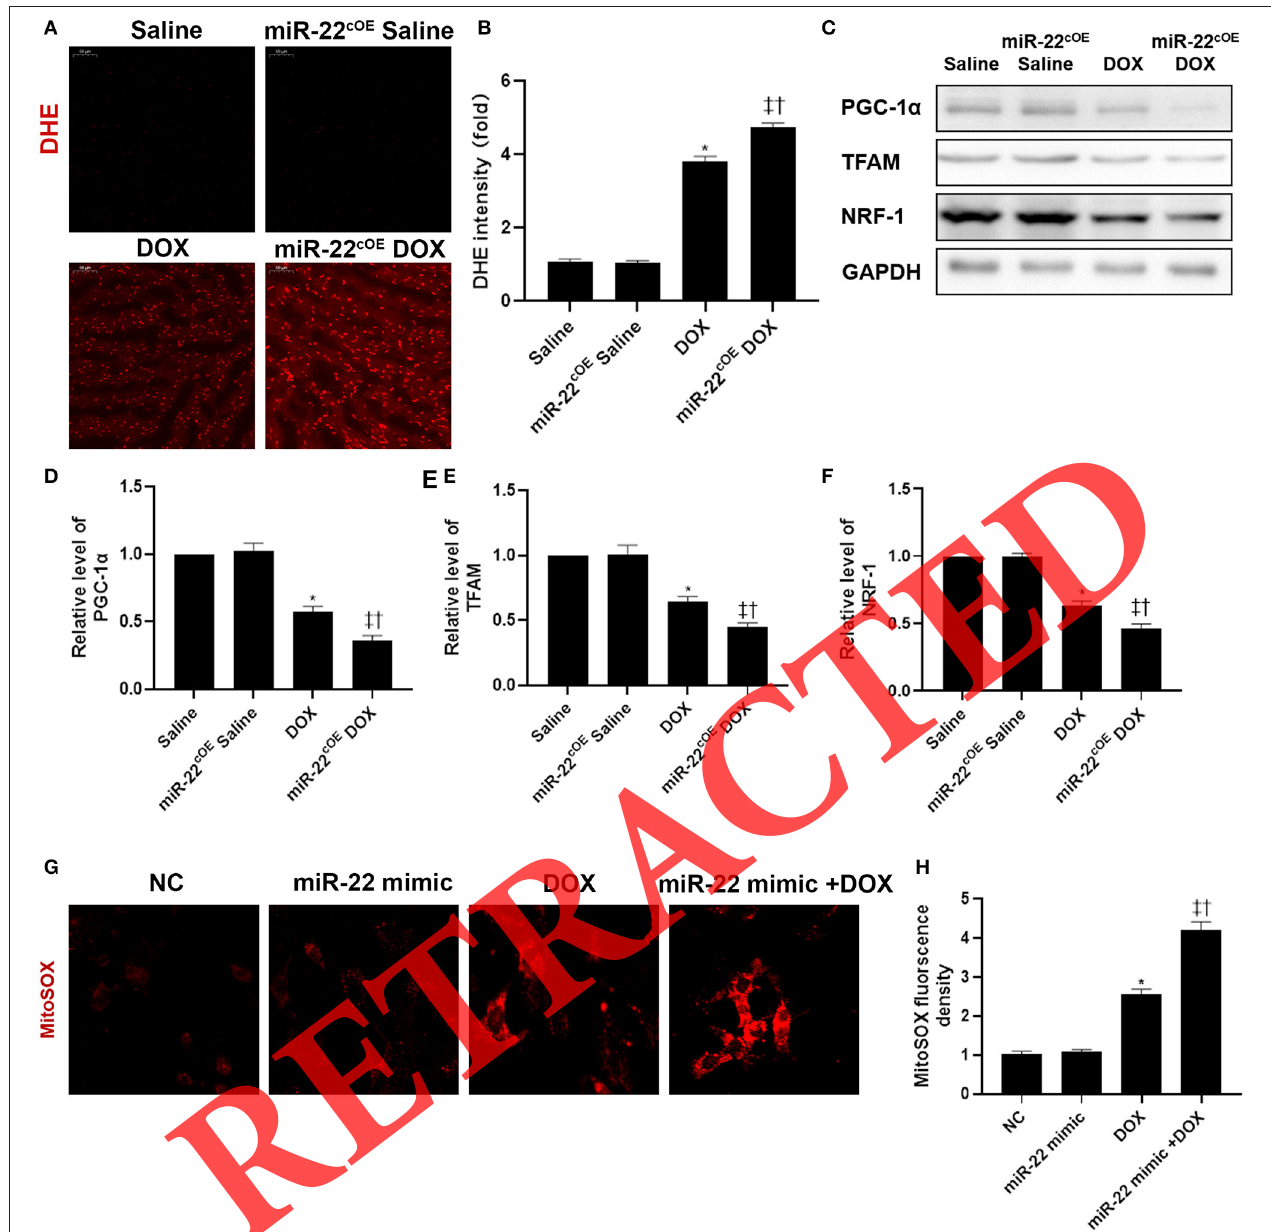
FIGURE 5 | Overexpressing miR-22 aggravates mitochondrial dysfunction in DOXIC. (A,B) Representative images of DHE staining, (C) Representative images of blots, (D) Relative PGC-1 α protein level ratio, (E) Relative TFAM protein level ratio, (F) Relative NRF-1 protein level ratio, Data were expressed as mean ± SEM. * P < 0.05 vs. saline group, ‡ P < 0.05 vs. DOX group, † P < 0.05 vs. miR-22 cKO group. (G,H) Representative images of mitochondrial ROS in neonatal mice cardiomyocytes, Scale bars = 50 µ m. * P < 0.05 vs. NC group, ‡ P < 0.05 vs. NC + DOX group, † P < 0.05 vs. miR-22 mimic group. All the experiments were repeated three